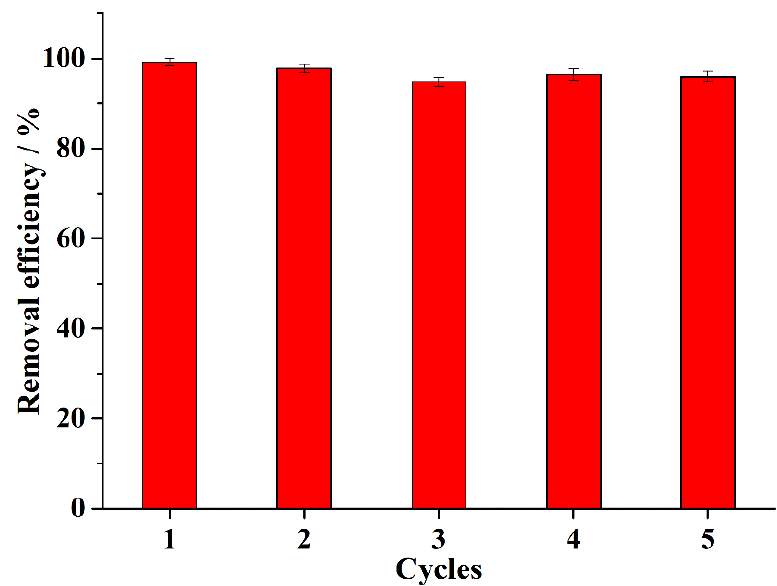
Figure 8. Removal e ffi ciency of Pb 2 + by Alg–PAM in five adsorption–desorption Figure 8. Removal efficiency of Pb 2+ by Alg–PAM in five adsorption–desorption cycles.